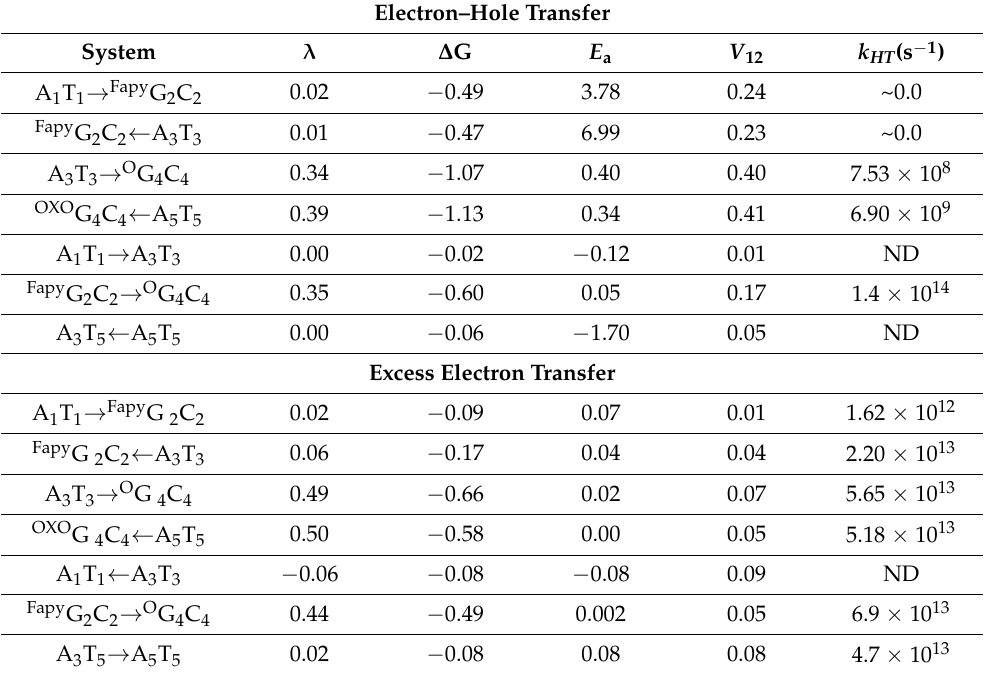
Table 4. Charge transfer parameters. The ∆ G-driving force, λ -reorganization energy, E a -activation energy, V 12 -electron coupling, and k HT -charge rate constant of permissible transfer between base pairs of oligo- Fapy G , calculated at the m062x/6-31++G** level of theory in the aqueous phase and given in eV. Arrows indicate the direction of charge migration. The row data have been given in Table S4. Electron–Hole